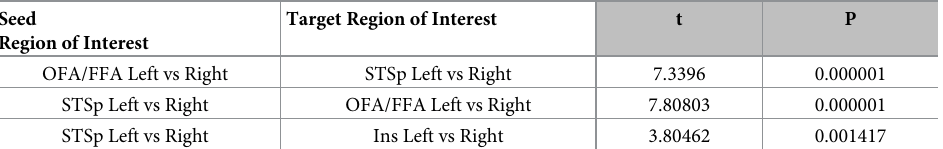
Table 2. T-test for dependent samples exploring the lateralization of the probabilistic path among bilateral regions of interest (ROIs) as seeds and the ipsilateral targets (p <